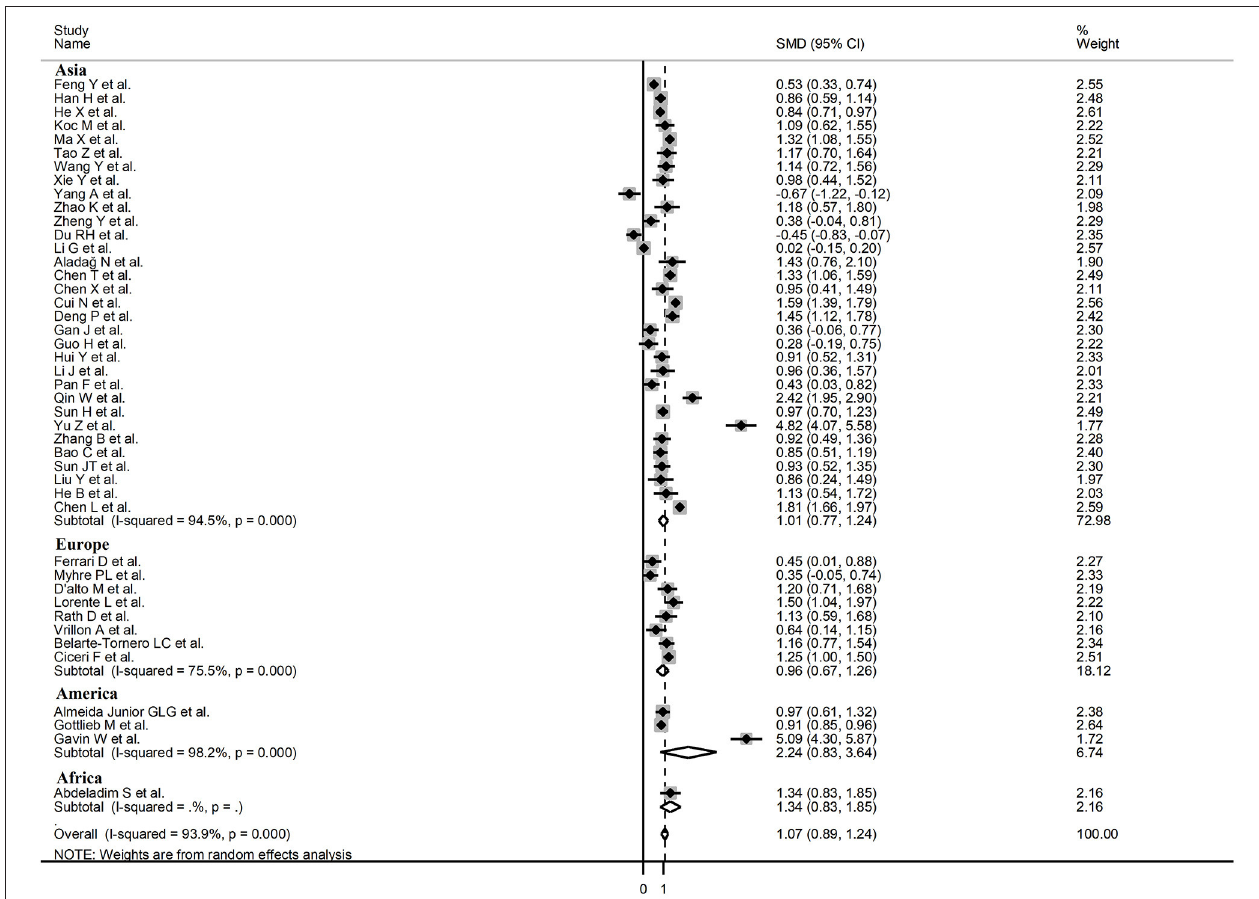
FIGURE 7 | Forest plot of studies examining BNP concentrations in patients with COVID-19 according to the geographic area where the study was